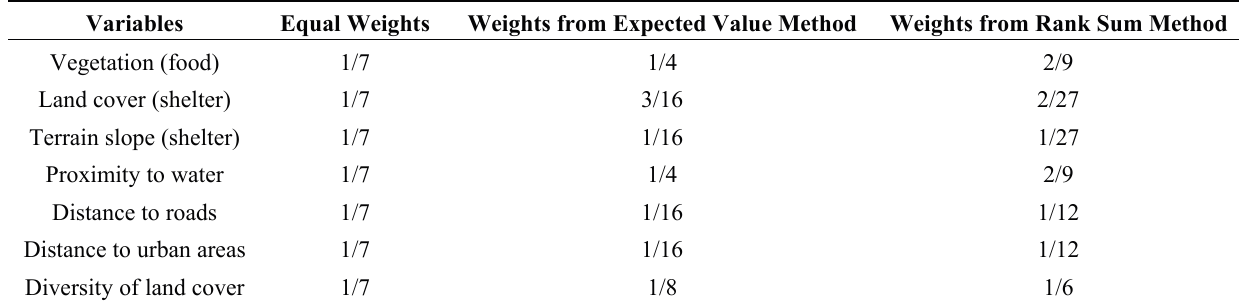
Table 1. Weightings assigned to each variable in three tested weighting